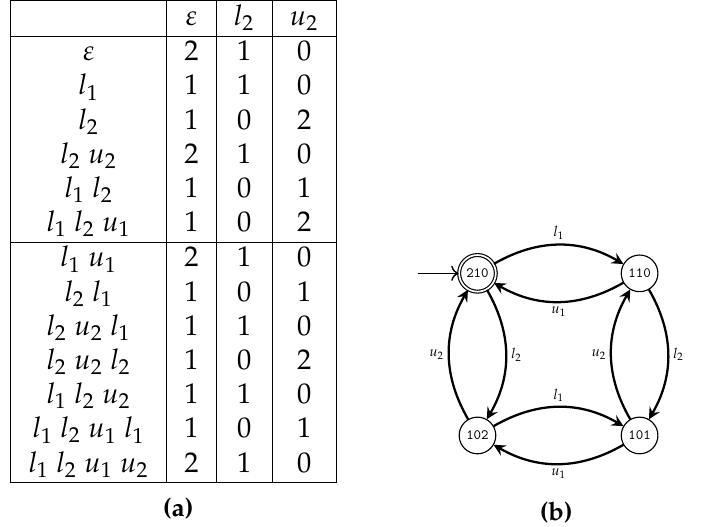
Figure 6. L ∗ —Second iteration. ( a ) The table updated with the counterexample and made closed and consistent; ( b ) second Figure 6. L ∗ – Second Iteration